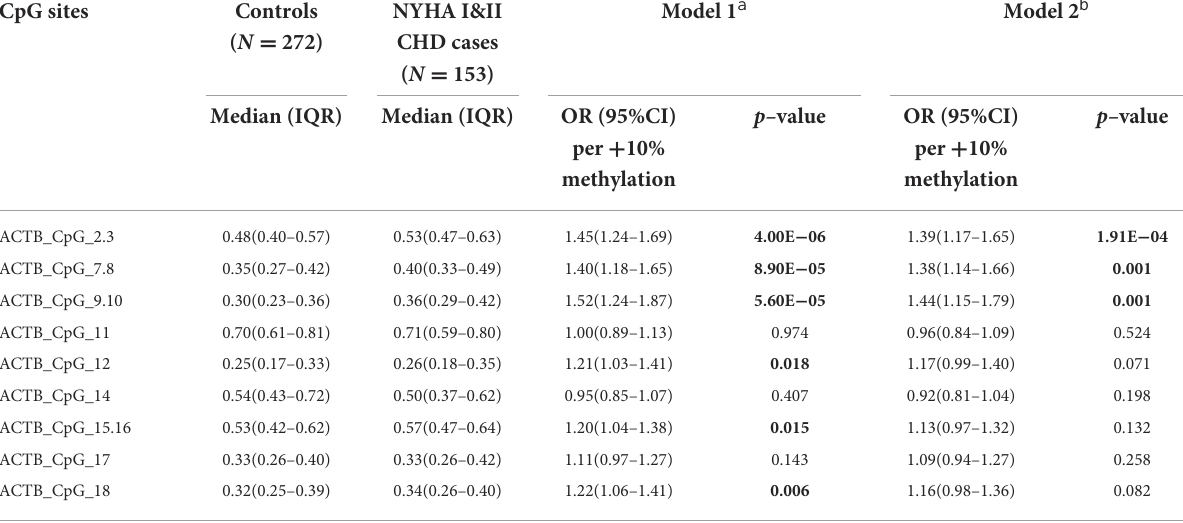
TABLE 7 Methylation difference of ACTB between NYHA I and II CHD cases and controls.